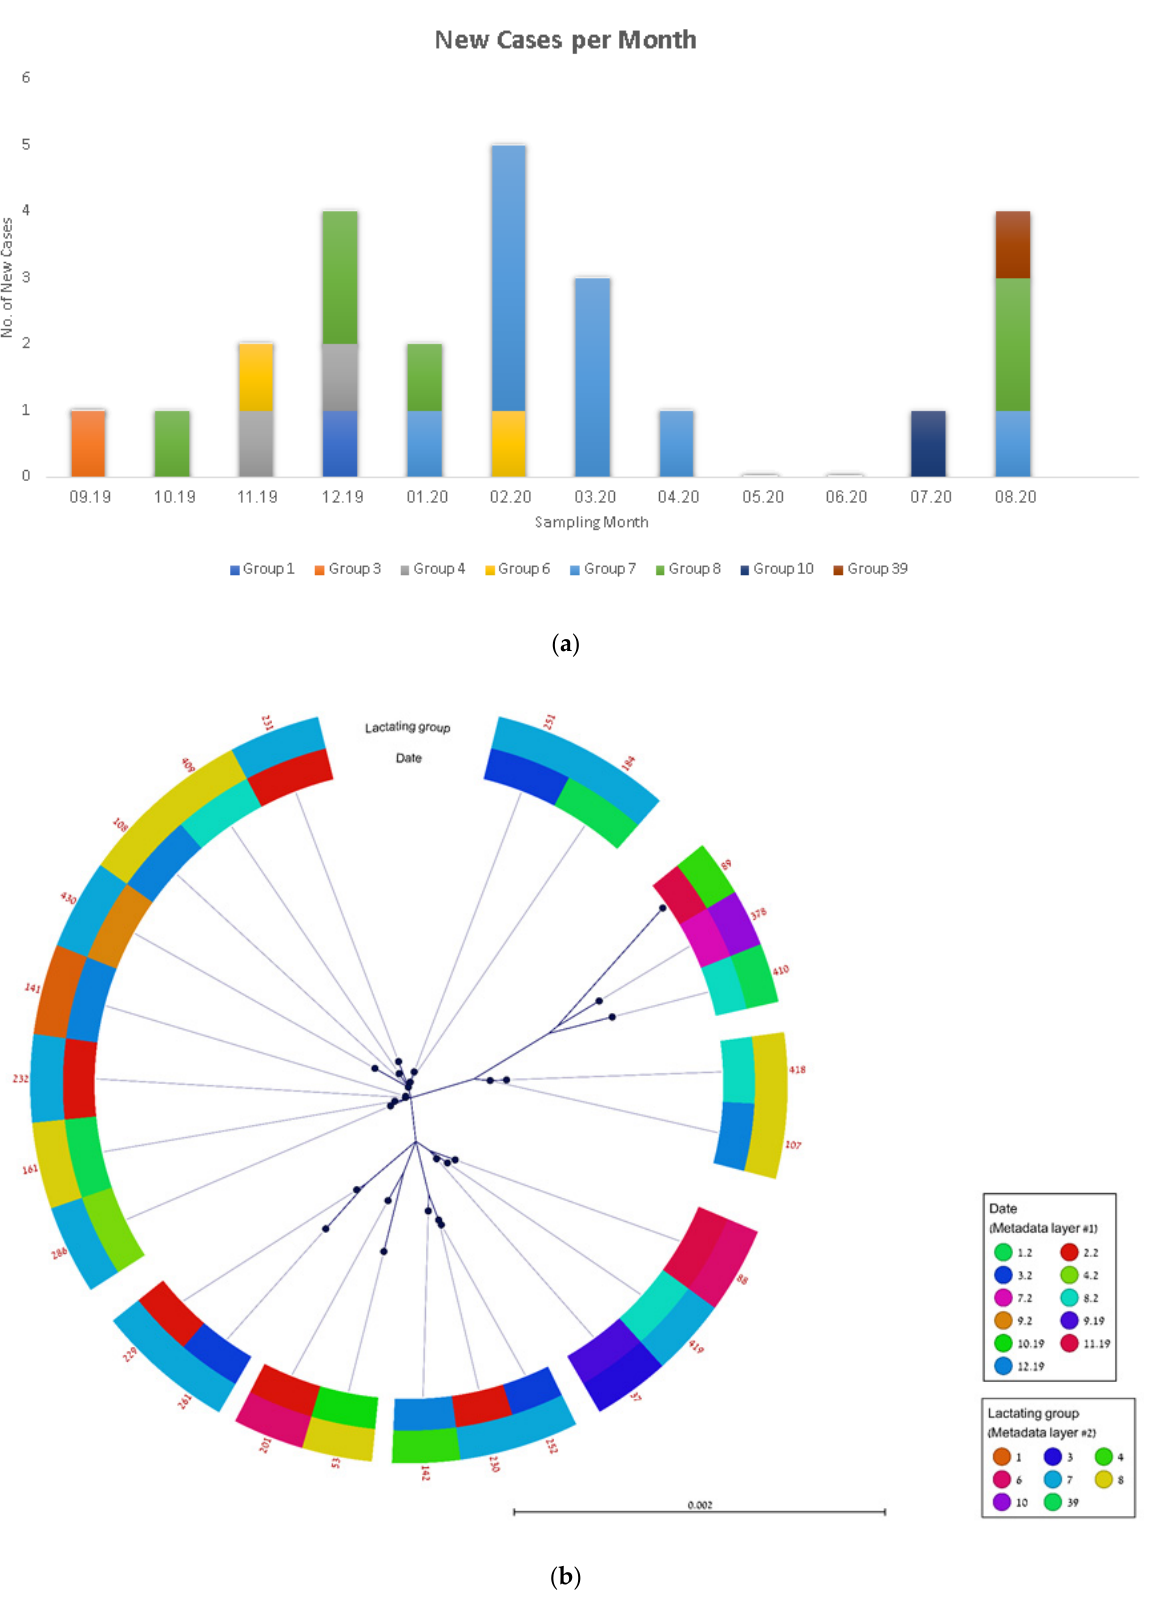
Figure 1. Transmission analysis of the t2873 strain within farm ‘A’. ( a ). Epidemic curve of S. aureus infection cases, September 2019–August 2020. ( b ). Phylogenetic analysis of 25 S. aureus t2873 isolates. Metadata layers include isolation month and milking group.